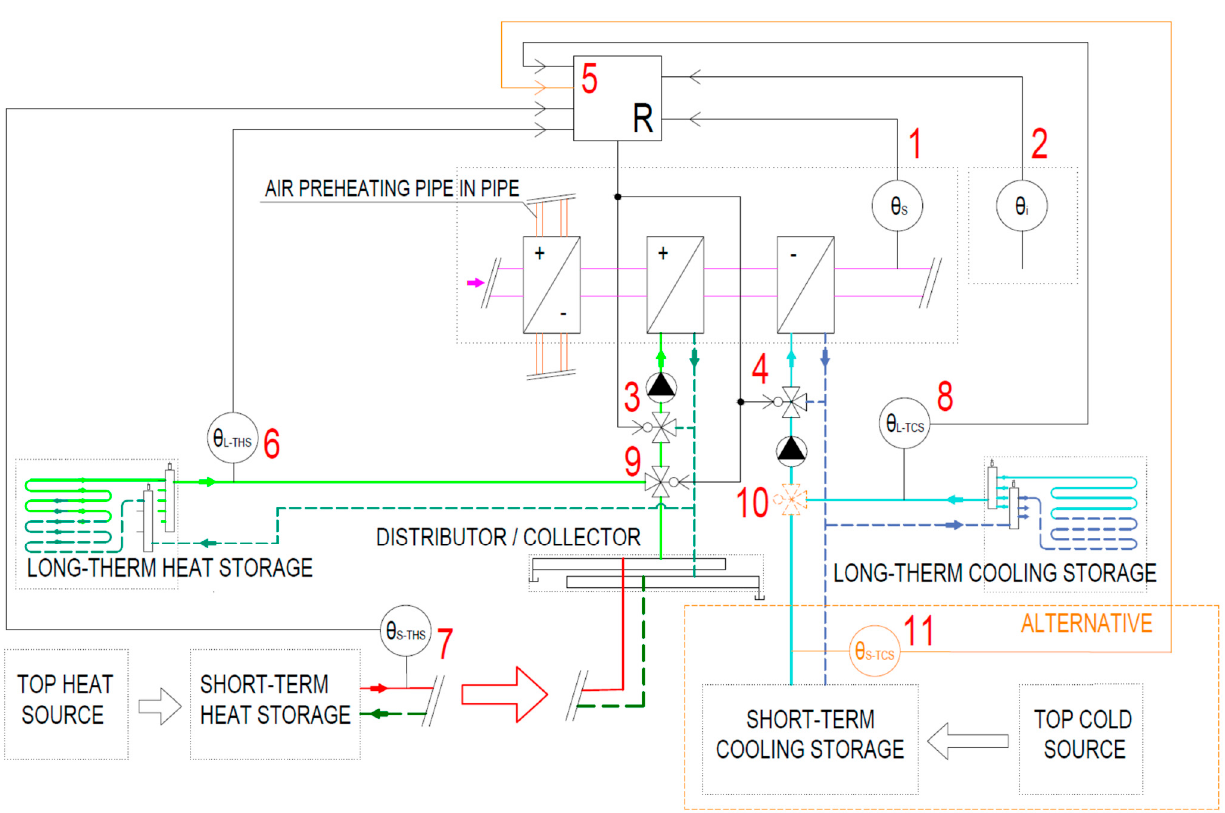
Figure 12. Block diagram of indoor air temperature control during the recuperative air handling unit operation. 1—supply air temperature sensor; 2—indoor air temperature sensor; 3—heater three-way heater mixing valve with actuator; 4—three-way distribution cooler valve with actuator; 5—controller; 6—heating water temperature sensor at the long-term heat storage tank output; 7—heating water temperature sensor at the short-term heat storage tank output; 8—cooling water temperature sensor at the long-term heat storage tank output; 9—three-way diverter valve with actuator for the heater; 10—three-way diverter valve with actuator for cooler; 11—cooling water temperature sensor at the short-term heat storage tank output.